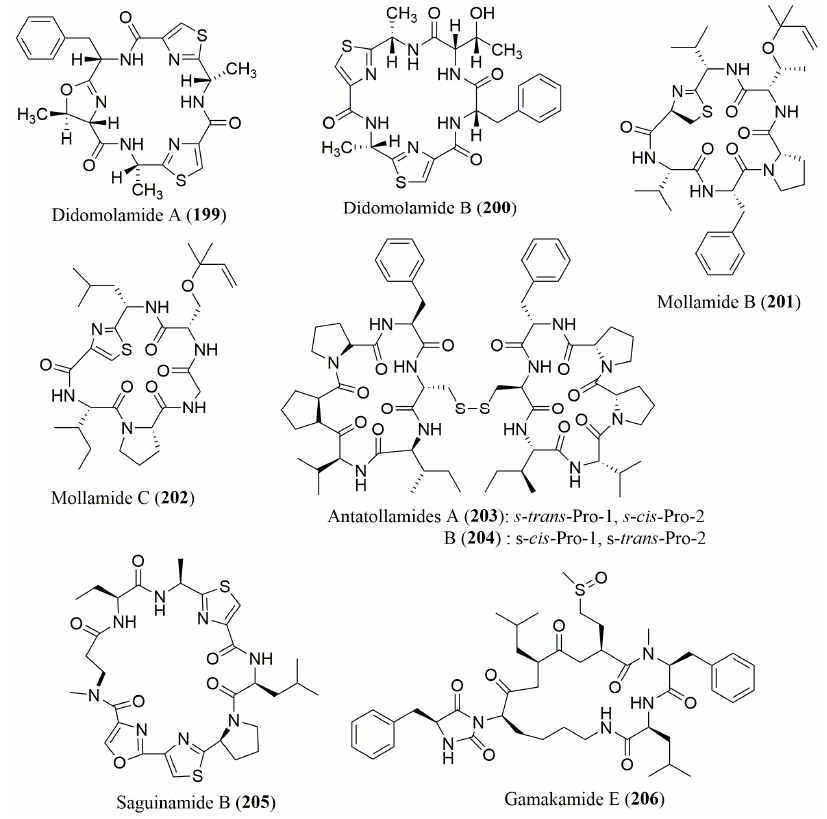
Figure 15. Structure of cyclic peptides 199 – 206 , isolated from marine invertebrates and marine algae. Table 9. Cyclic peptides from marine invertebrates and algae.